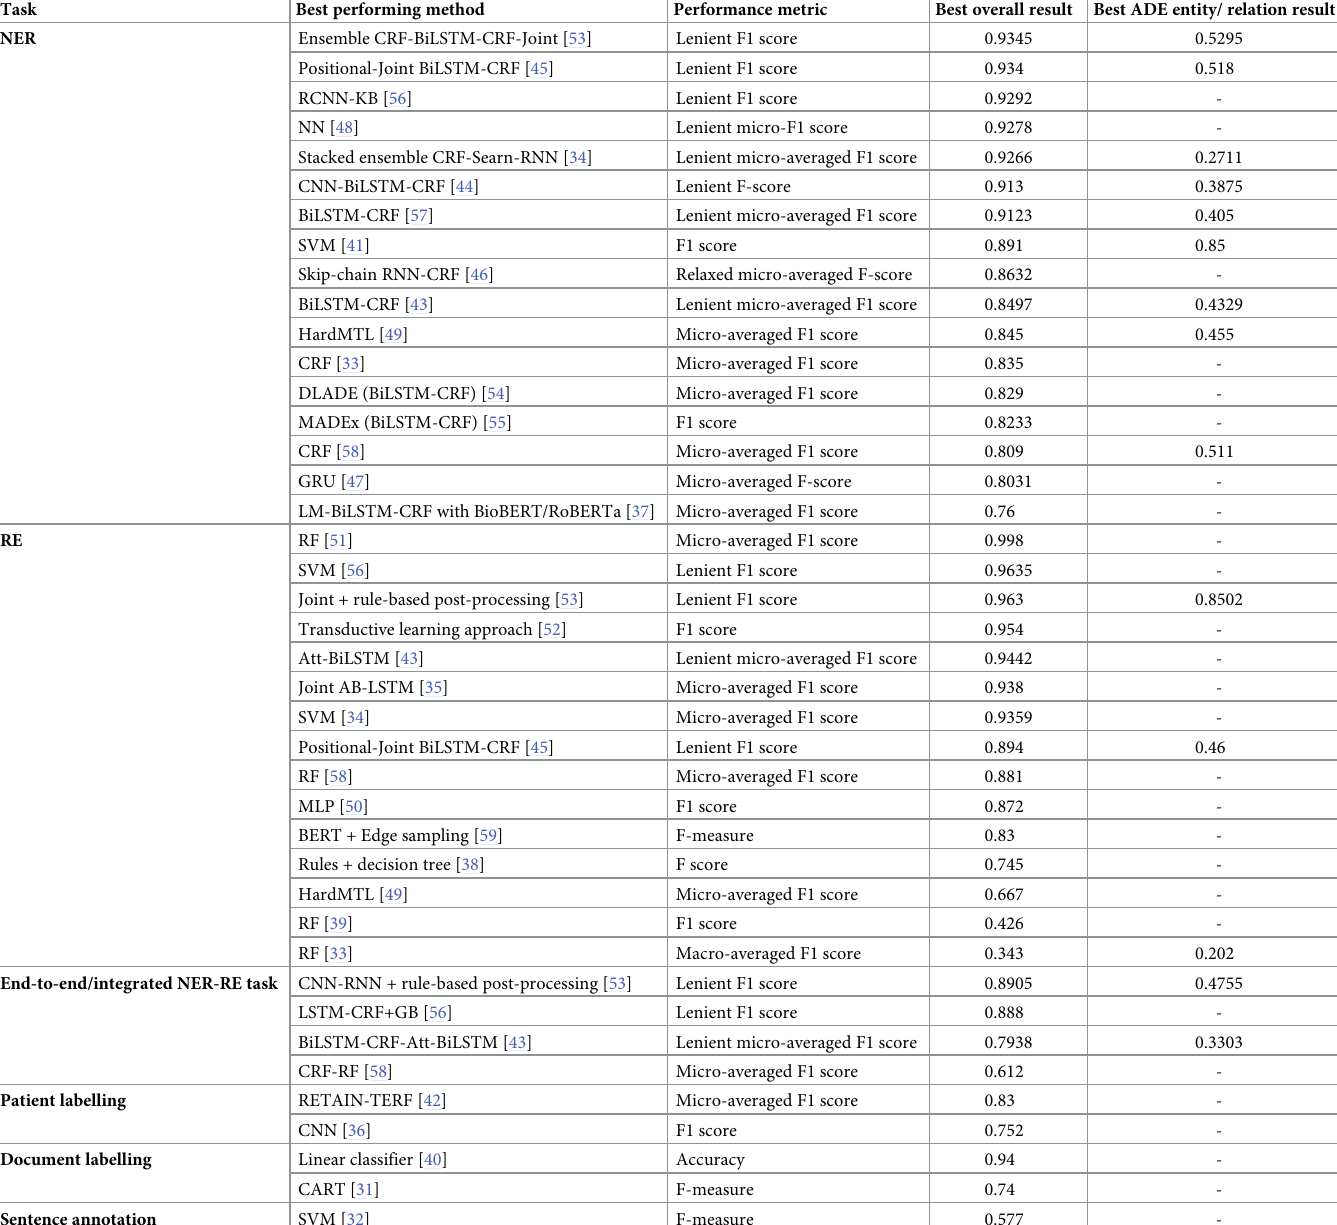
Table 5. Summary of single best reported result for overall performance and ADE entity or relation class performance by